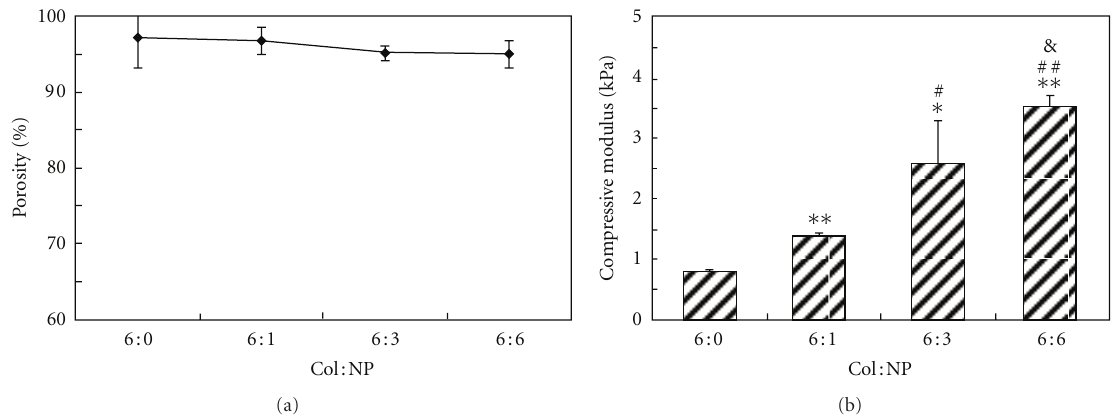
Figure 3: Porosity and compress modules of porous collagen sca ff olds integrated with PLLA nanoparticles. (a) Porosity (b) compress modules. n = 3, ∗ P < 0 . 05, ∗∗ P < 0 . 01 (compared to pure collagen sponges with Col:NP = 6 :0 (w:w)); # P < 0 . 05, ## P < 0 . 01 (compared to